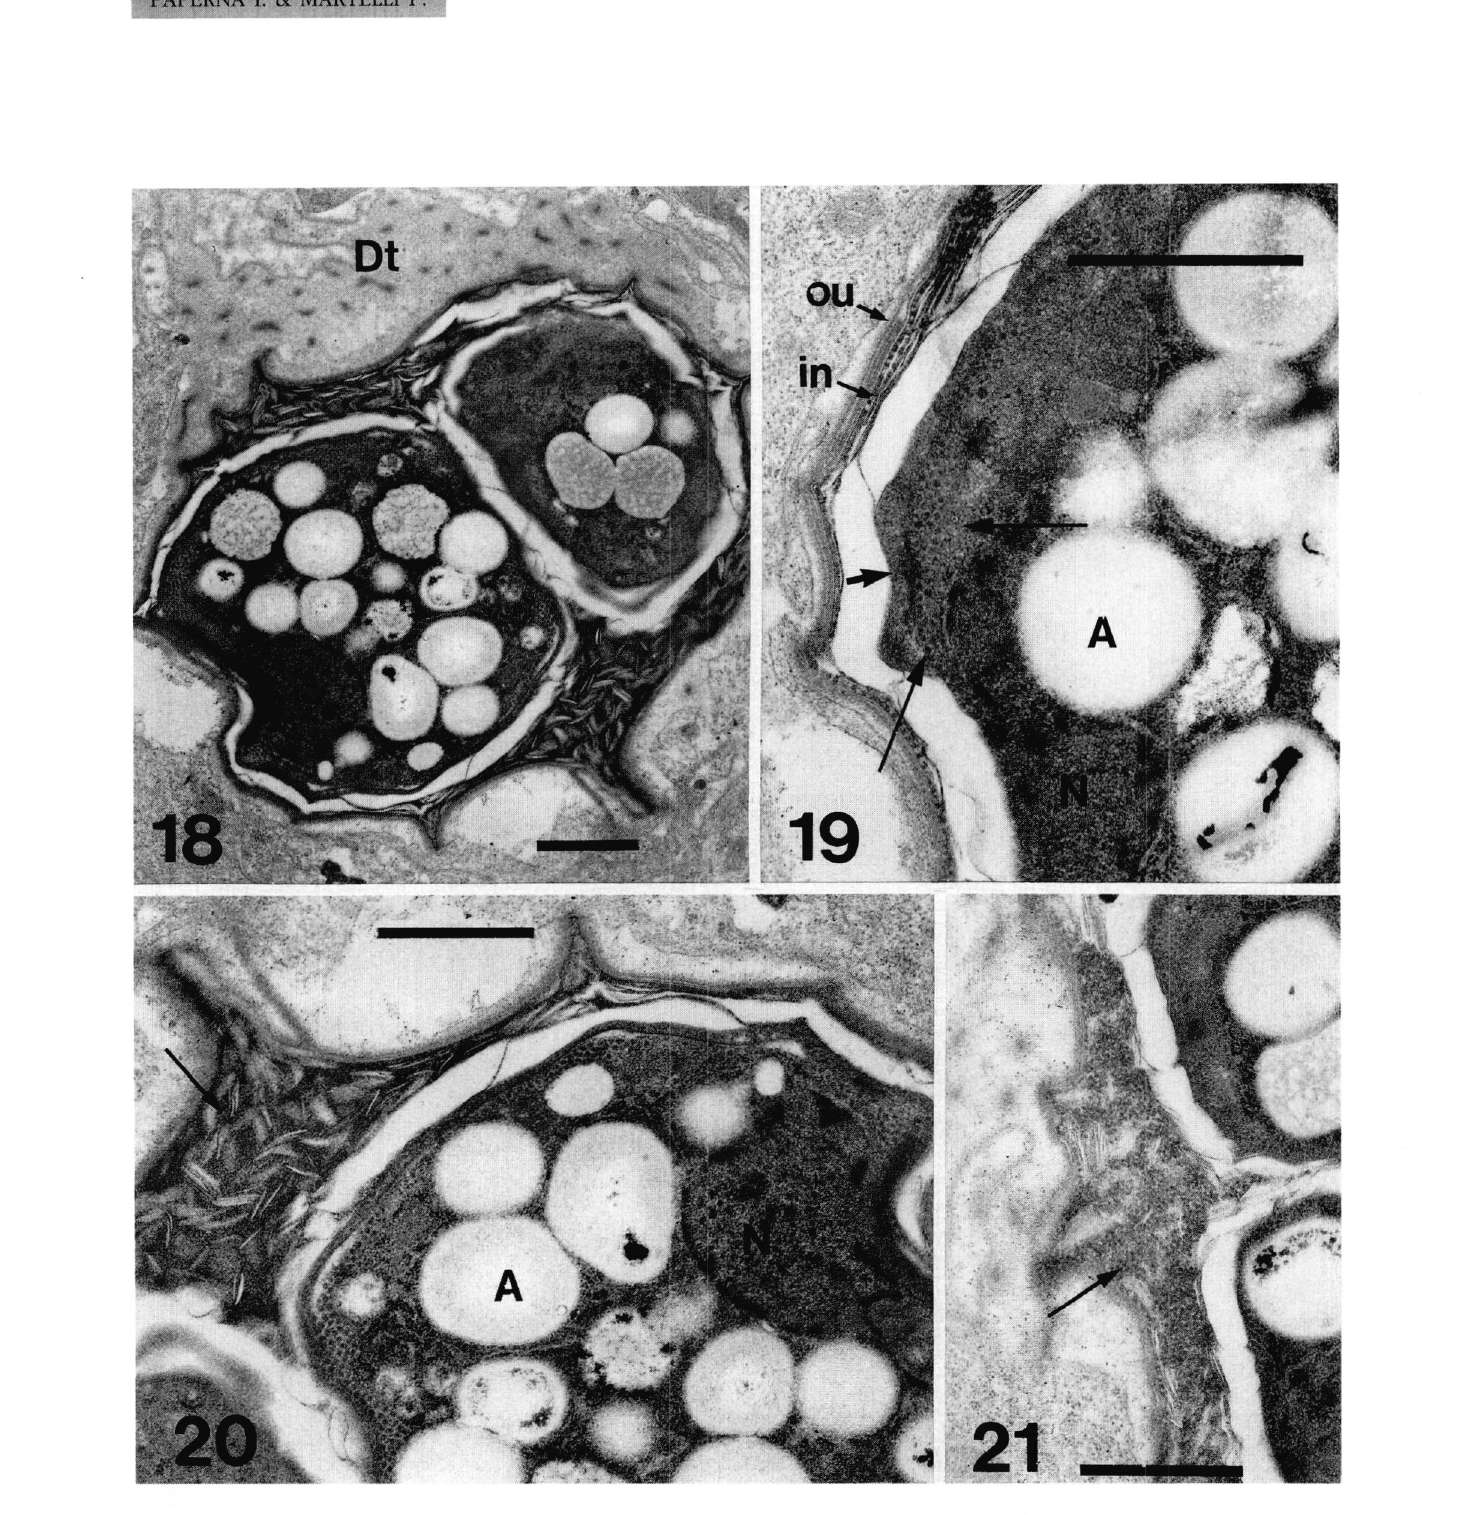
Figs 18-21: Sporulated oocysts. 18. Oocyst with two sporocysts, located alongside an inclusion of PV filling substance. 19. Detail of the oocyst wall: the wall hard on the outside and its innner layer separate into membranal strands impregnated with granular substance; the sporocyst is bound by a hard wall (thick arrow); note the densely packed granules in the cytoplasm (long arrow). 20. Crystalline deposits (arrow) between the walls. 21. Gra nular deposite (arrow) between the oocyst and sporocyst walls.